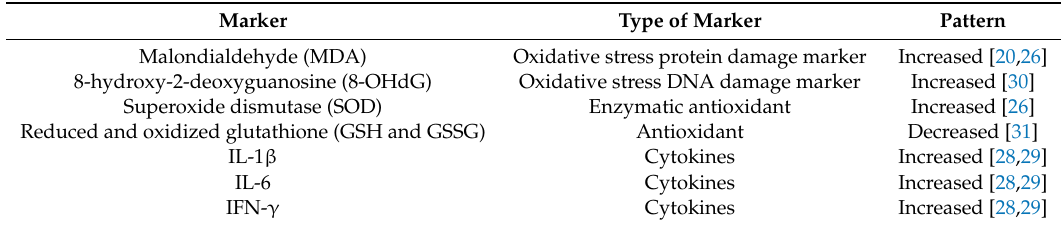
Table 2. Levels of some GCF parameters as possible future periodontitis biomarkers in periodontitis patients compared with